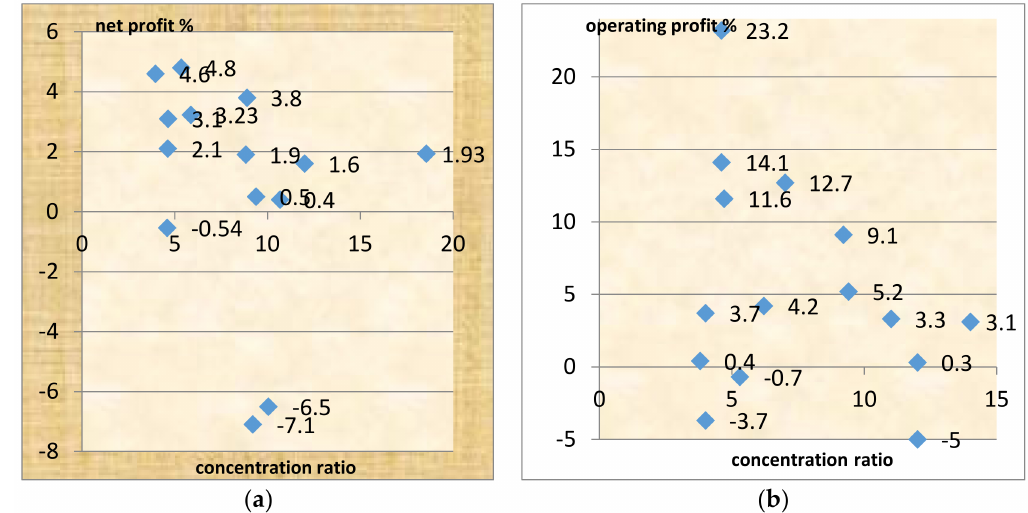
Figure 9. Scatters of ( a ) net and ( b ) operating profit as % of turnover and concentration ratios CR 4, and CR 10 over 3 routes for 14–15 major container carriers (2002). Source: Author, regression and data from Lam et al.